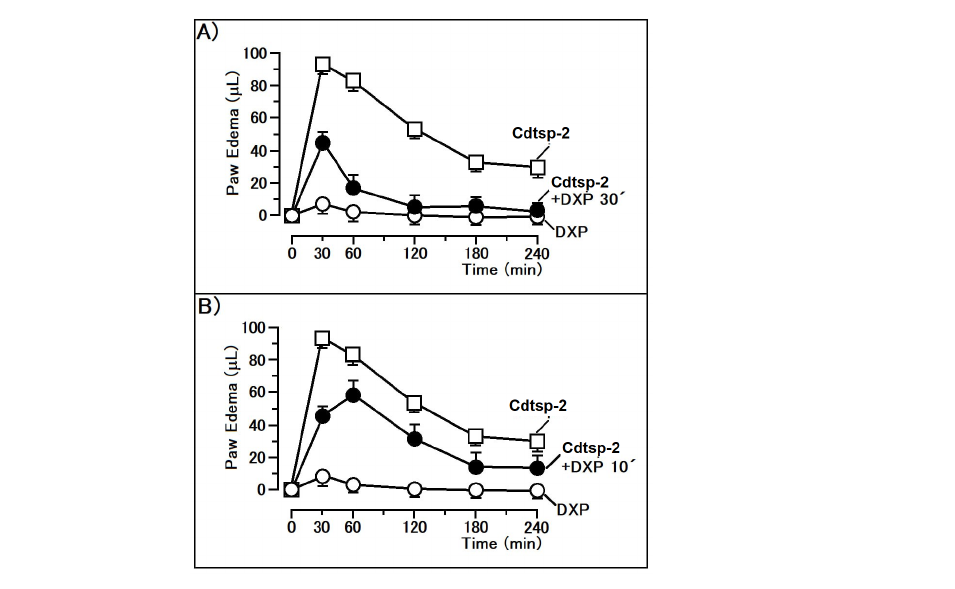
Figure 4. ( A ): Graph of paw edema volume ( µ L) of Swiss mice during inflammation, induced by the presence of Cdtsp-2 venom or the toxin with DXP (Dexametasone), which was injected 30 min before protein application. ( B ): Plot of the paw edema volume ( µ L) of Swiss mice during inflammation, induced by the presence of Cdtsp-2 or the toxin with DXP injected 10 min after the protein application. Both assays were performed using 10 µ g of protein and 50 µ g of DXP. Results were expressed as mean ± standard deviation ( n = 5), and treatments with significant difference marked with (*) (Two-way ANOVA, with Bonferroni as a posteriori test, F = 150.0 and p < 0.001).